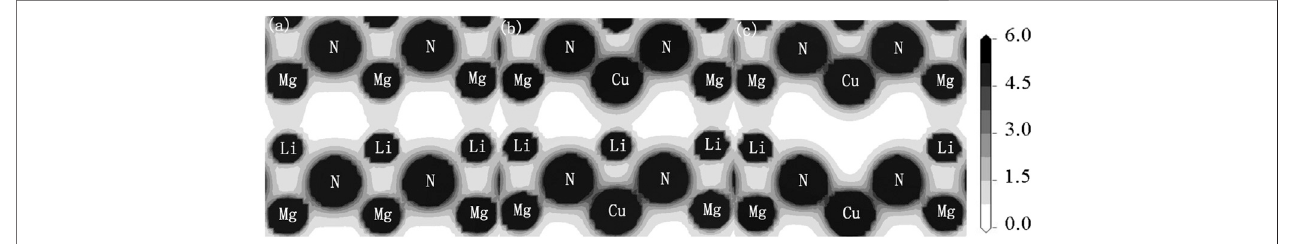
FIGURE 6 | The maps of charge density for Li 1-y (Mg 1-x Cu x )N in (2,2,1) surface. (A) LiMgN; (B) Li(Mg 0.875 Cu 0.125 )N; (C) Li 0.9375 (Mg 0.875 Cu 0.125 )N.